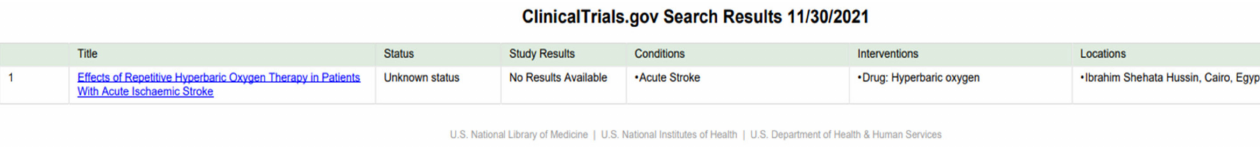
Figure 5. Clinical trials for Hyperbaric Oxygen Therapy interventions in acute ischemic